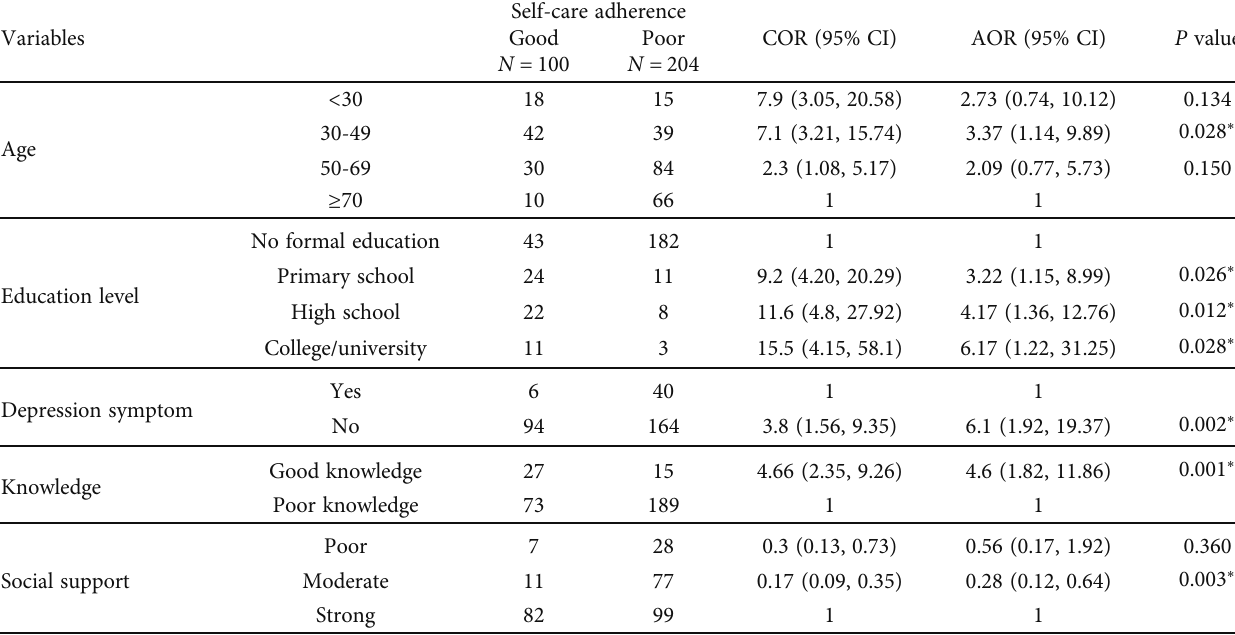
Table 6: Logistic regression analysis result of factors signi fi cantly associated with adherence to heart failure SCRs in multivariate analysis in West Gojjam Zone public hospitals, Ethiopia,